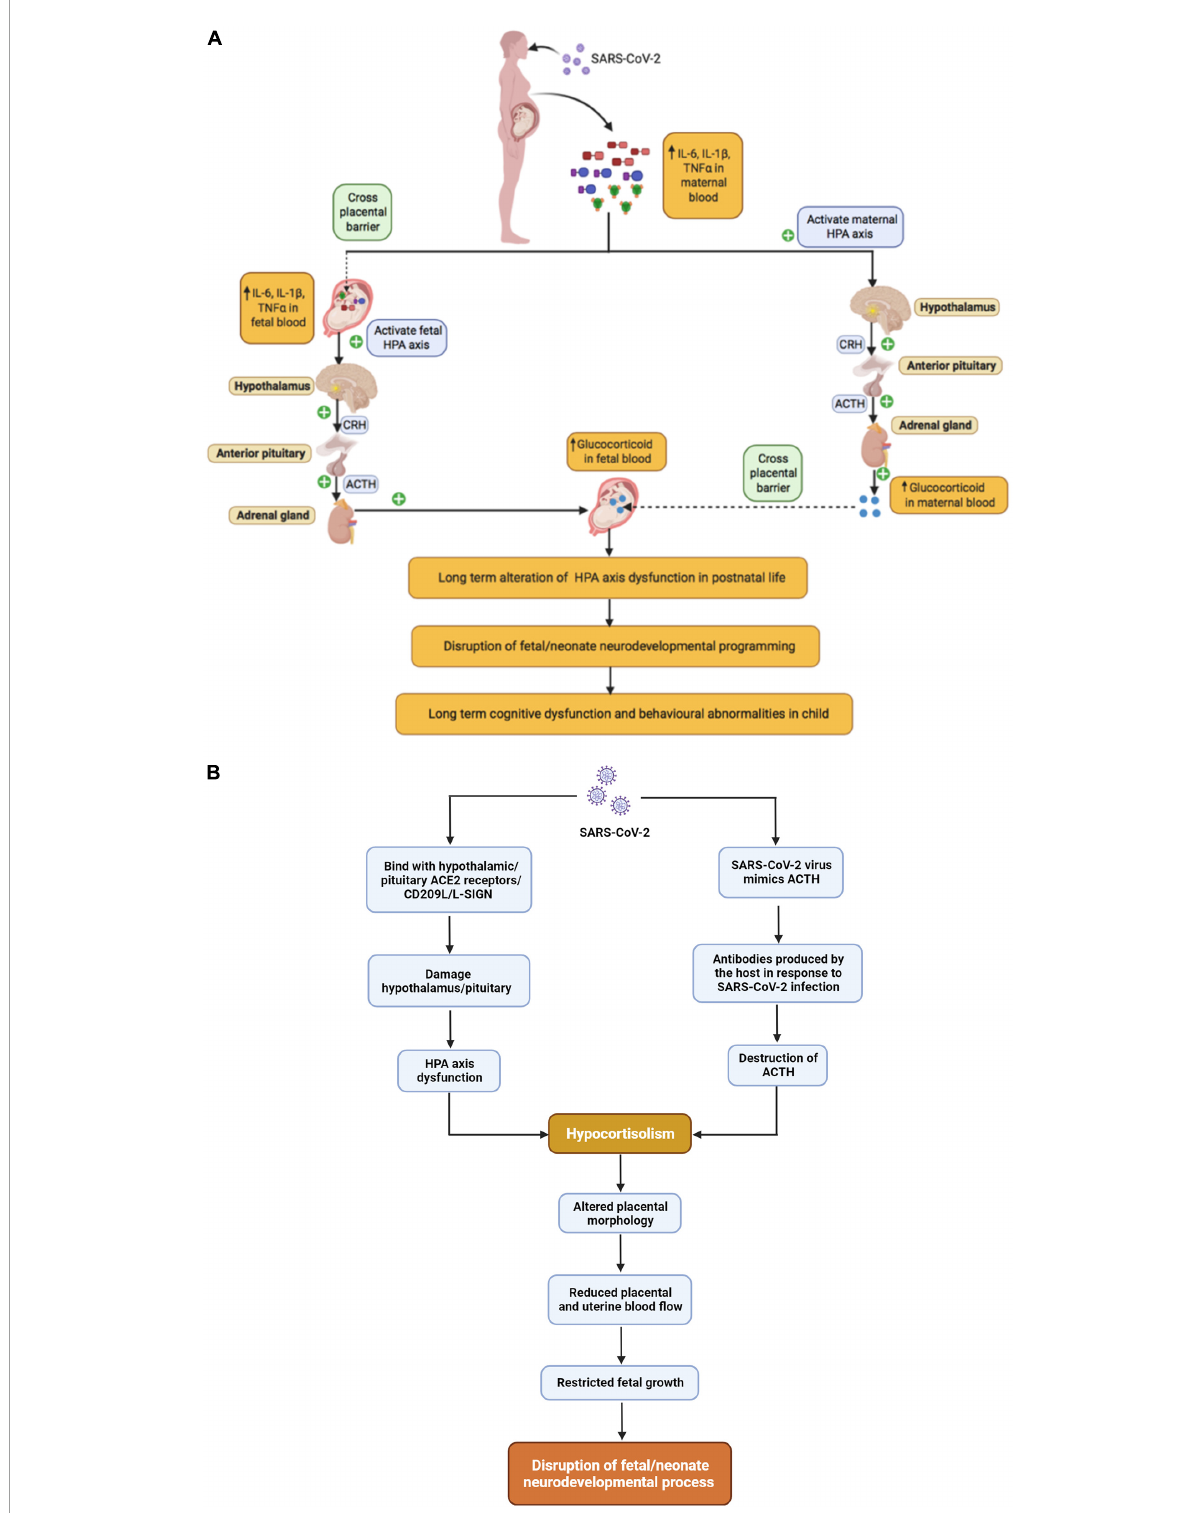
FIGURE4 The relationship between maternal SARS-CoV-2 infection and Fetal HPA axis modulation, (A) SARS-CoV-2 infection and hypercortisolism, (B) SARS-CoV-2 infection and hypocortisolism.